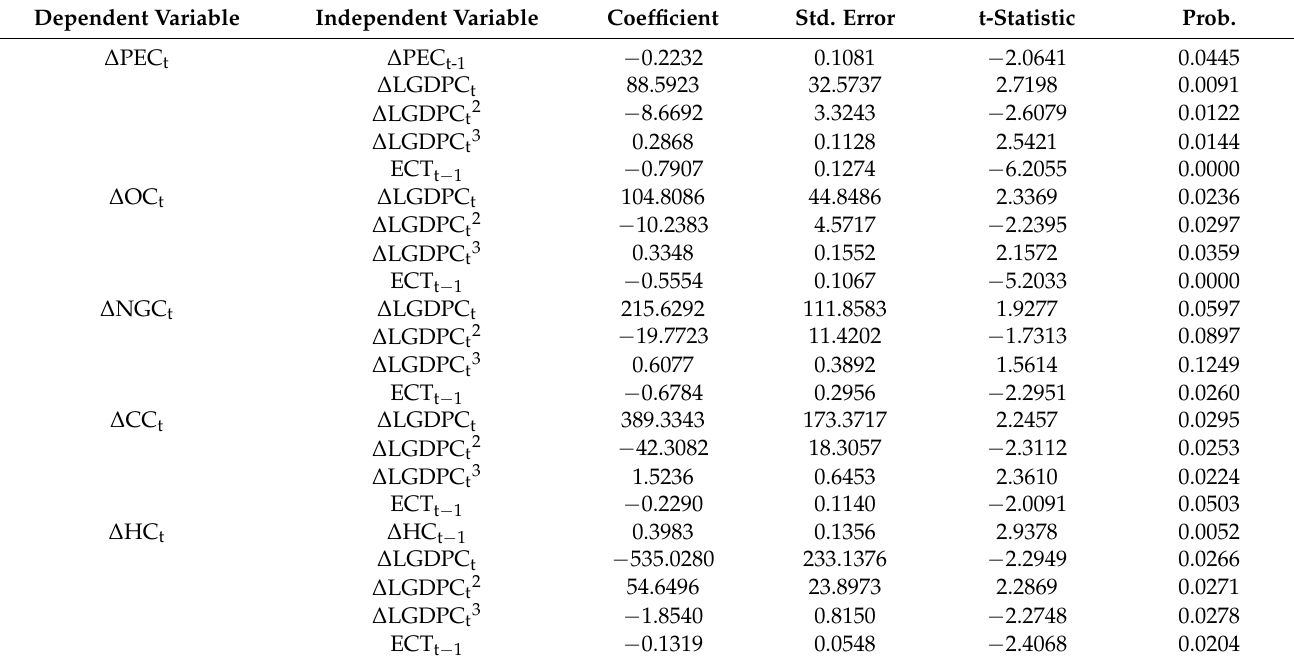
Table 5. Short run